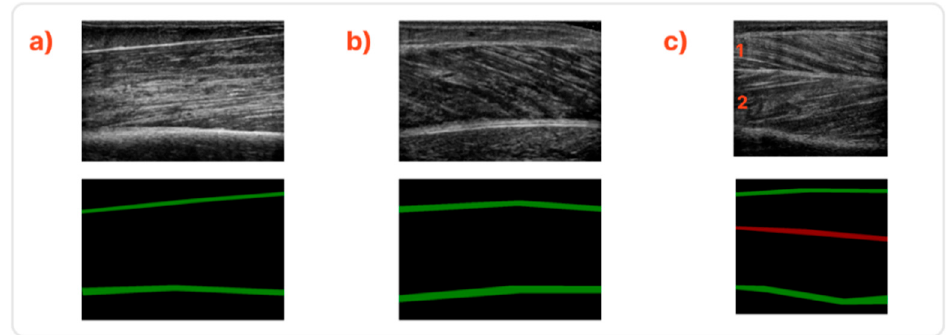
Figure 1. Sample ultrasound images along with their annotations. ( a ) Sample from the BB muscle, ( b ) from the GCM muscle, and ( c ) the TA muscle. The TA muscle comprises two compartments divided by the central fascia in the middle. These are depicted as 1 and 2.